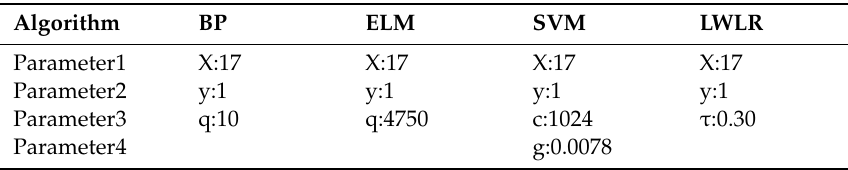
Table 4. The parameters of the four different methods.